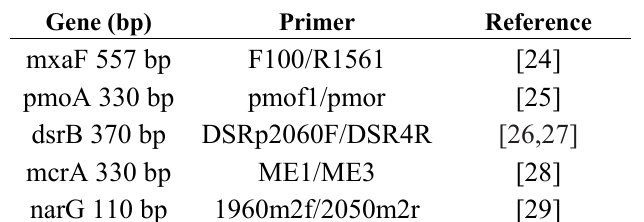
Table 1. Primers used for screening mxa F, pmo A, dsr B and mcr A and genes.